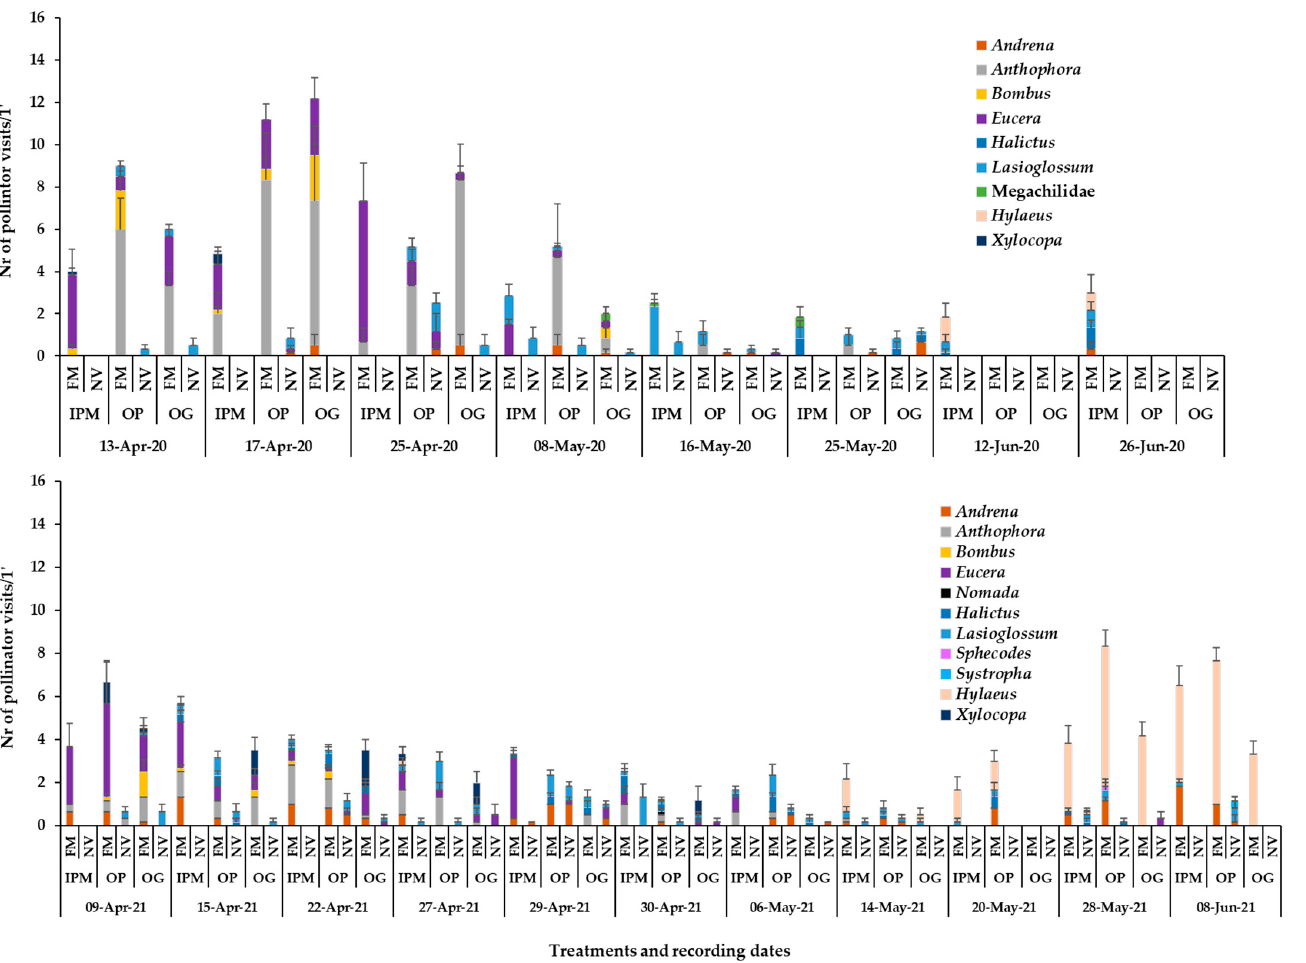
Figure 5. Mean numbers of wild bees recorded in groundcover patches (1 min/6.4 m 2 ) in apple or- chards in 2020 and 2021. Wild bee taxa are indicated by different colour in each column. FM: sown flowering mixture; NV: natural vegetation (wild plants). IPM: IPM orchard, OP: organic palmette orchard, OG: organic goblet orchard. Vertical bars represent standard error of means.